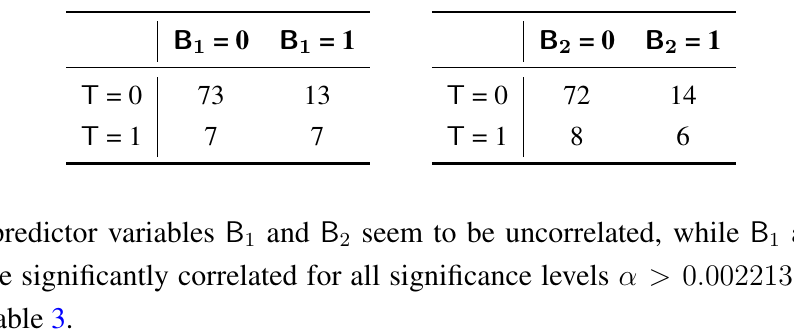
and B , respectively, of datasets RANKIT and 1 2